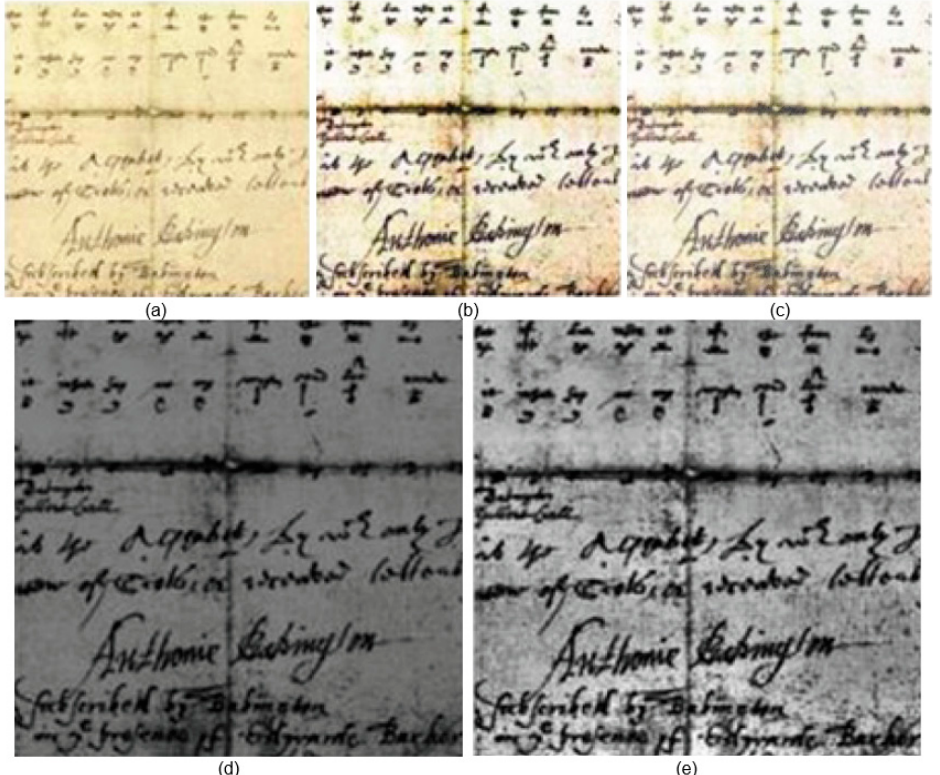
Figure 6. Qualitative results using Noisy Office dataset [30]: ( a ) input image, ( b ) S. Kang [2], ( c ) S. K. Jemni [3], ( d ) proposed LWT and SWT bi-cubic interpolation result, ( e ) proposed final image.